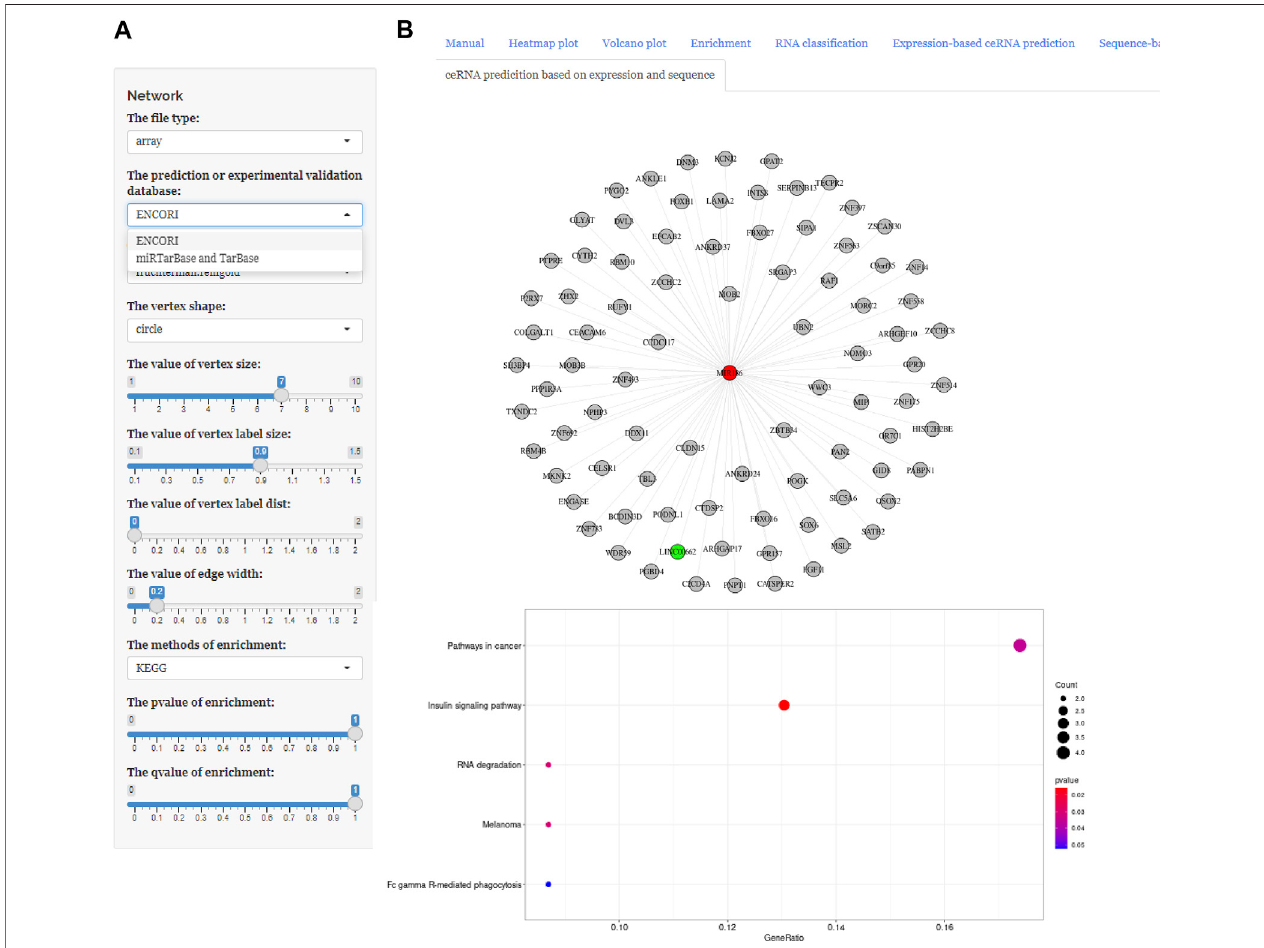
FIGURE 6 | Using ceRNAshiny to generate “ ceRNA prediction based on expression and sequence. ” (A) Panels to adjust parameters. (B) The generated ceRNA network and its enrichment results based on PCC arithmetic and database sources using the template dataset.